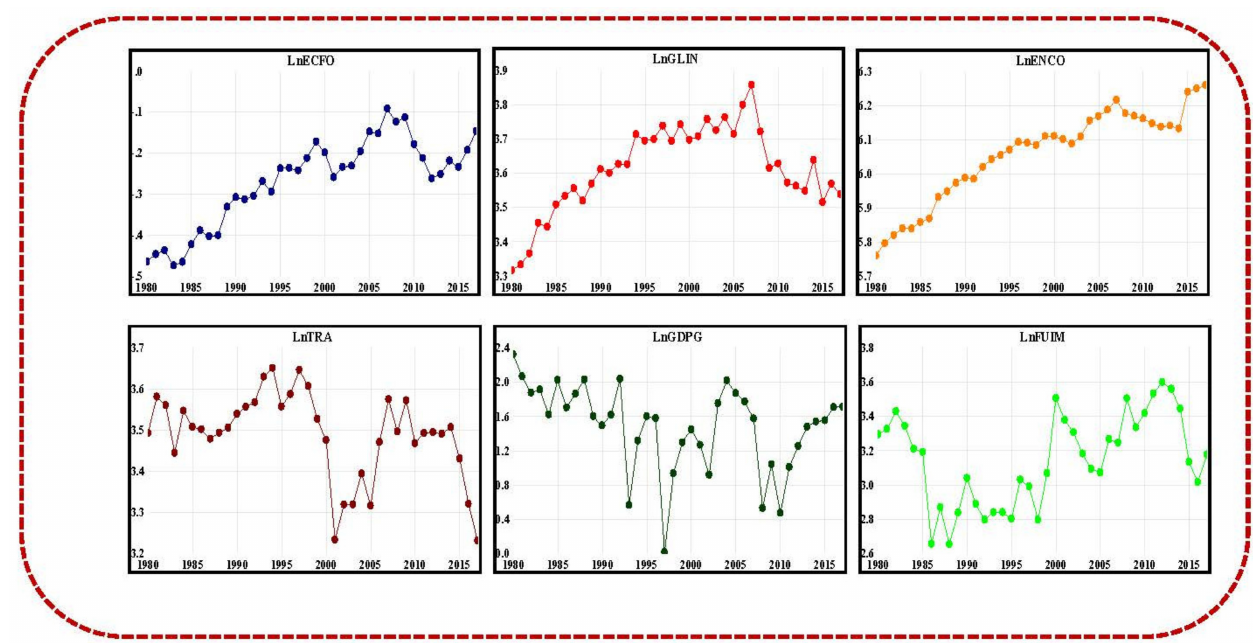
Figure 1. Trends of the study